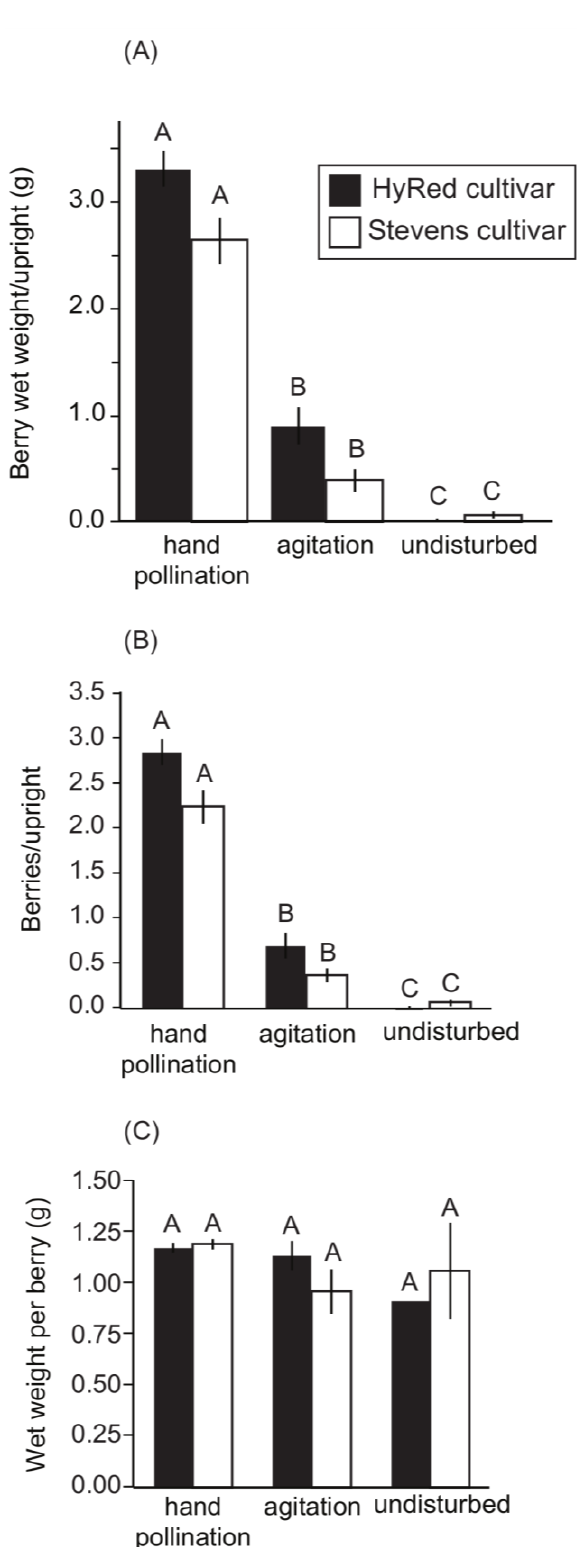
F IGURE 2: Metrics of pollination success for the cranberry cultivar “HyRed” (black bars) and “Stevens” (white bars) as measured in the greenhouse: (A) yield estimate (mean wet weight per upright ± SE), (B) number of berries per upright (mean ± SE), and (C) wet weight per berry (mean ± SE). Letters represent significant differences (P < 0.05) between